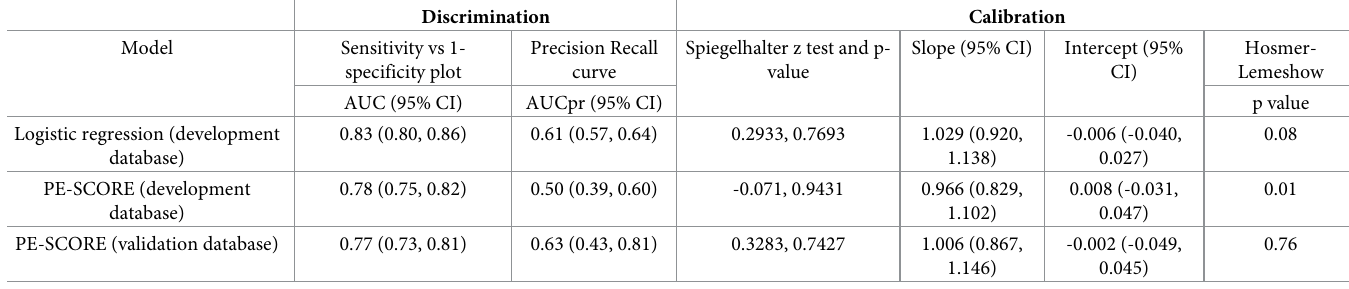
Table 5. Discrimination and calibration